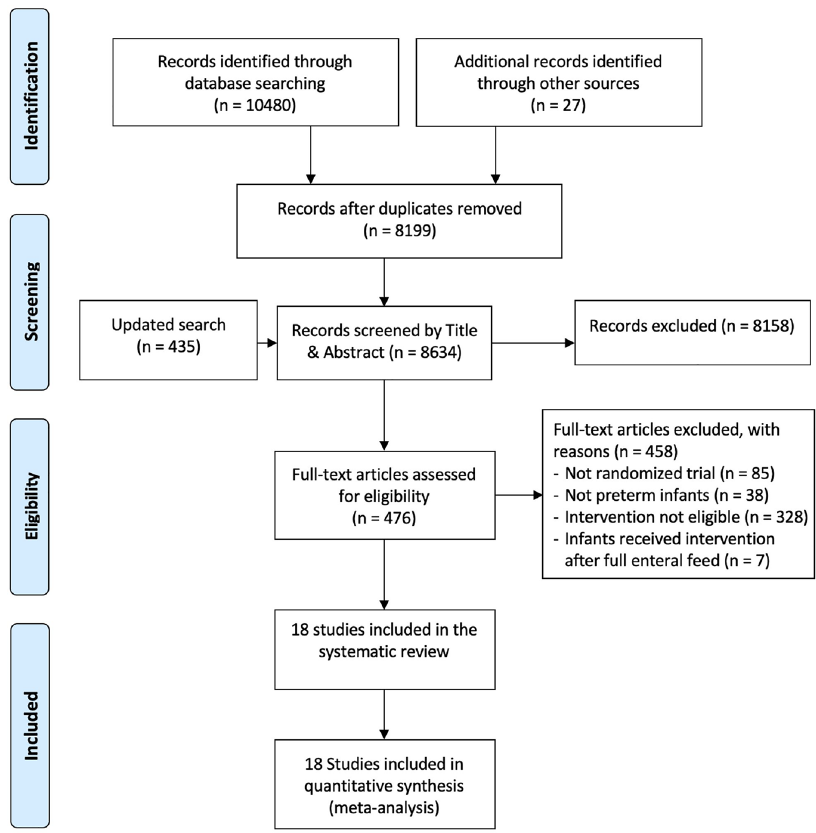
Figure 1. PRISMA Flow diagram of study